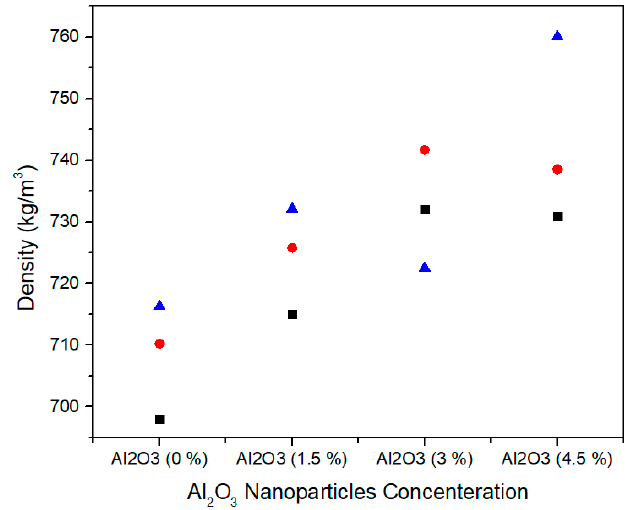
Figure 15. Numerical values of density of various treatments of alumina nanoparticles. Table 6 summarizes the ANOVA statistical approach of density values for three treatments of 0.0%, 1.5%, 3.0%, and 4.5% alumina nanoparticles. The 0.0% alumina containing medium density fiberboard has density mean value of 708.19 kg / m 3 and variance of 86.31. While 1.5%, 3.0%, and 4.5% alumina containing medium density fiberboard have 724.3, 732.06, and 743.17 density mean values with variance 75.18, 91.97, and 228.5, respectively. These density values are statistically altered from each other and the single factor ANOVA consequences confirm that the probability ( p -value) is